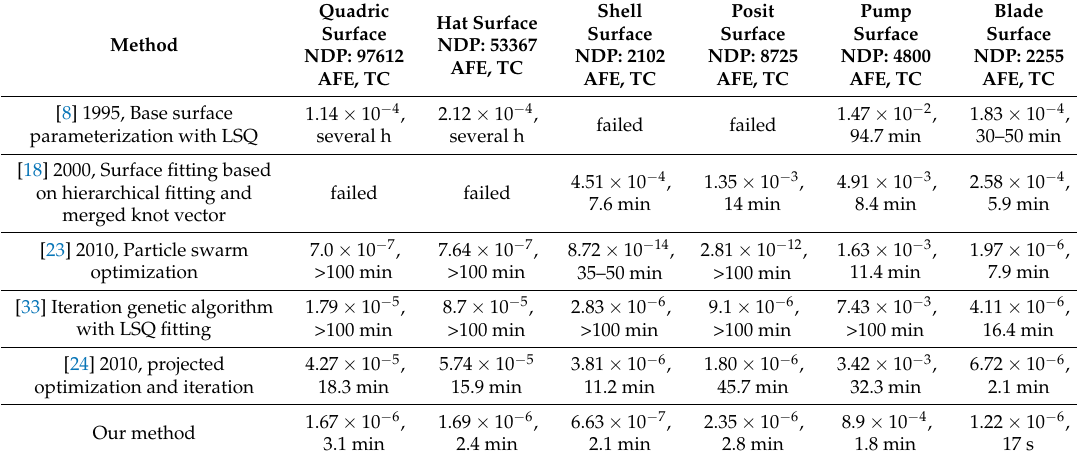
Table 1. This is a comparison of proposed method with four other alternative methods. NDP presents the number of data points. AFE is the average fitting error, and TC denotes the time